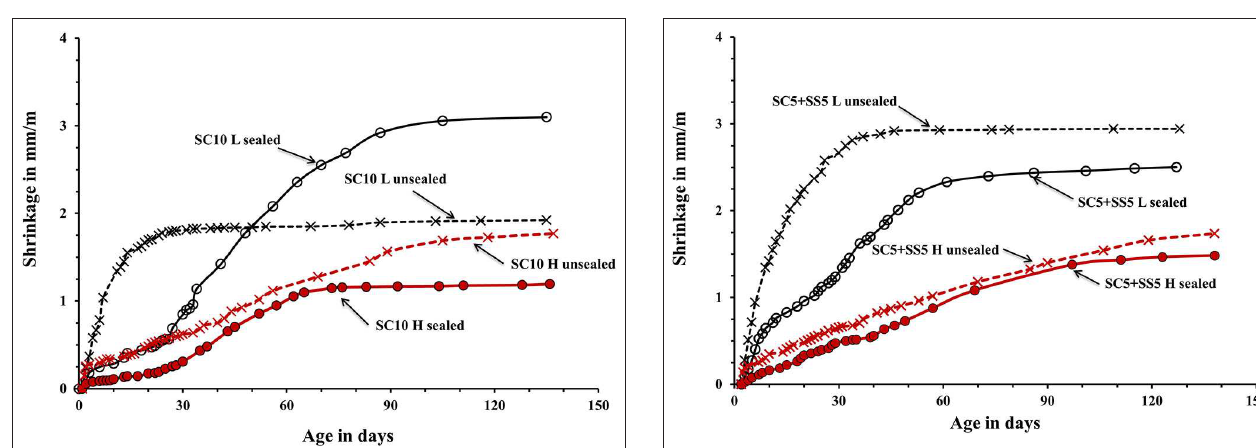
be also less homogenous with larger amount of pores (Helmuth